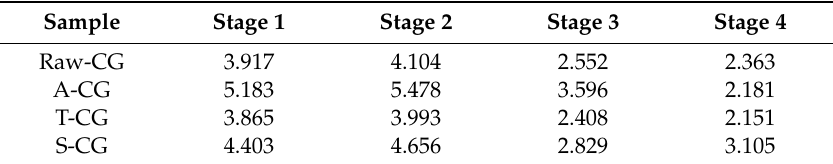
Table 5. Coe ffi cient in di ff erent stages of coal gangue subgrade. Table 5. Coefficient in different stages of coal gangue subgrade.